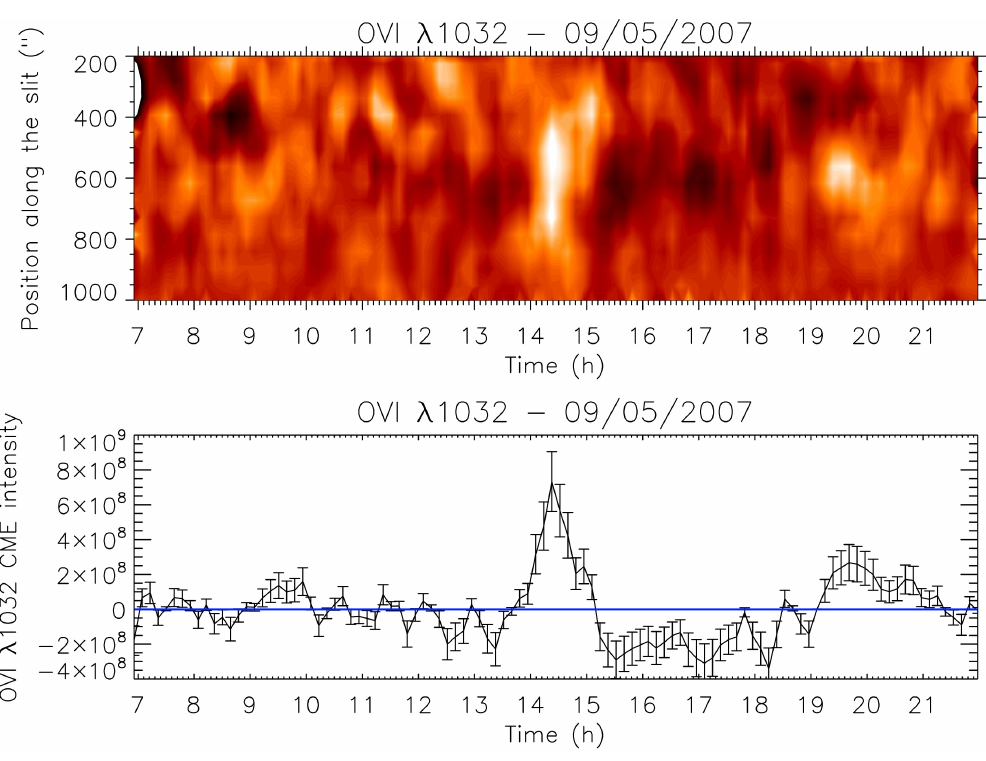
Fig. 7. Top: the evolution of the O VI λ 1031.9 line intensity along the southward part of the UVCS slit as a function of time. Positions along the slit (y-axis) are given in arcsecs measured from the slit center; the pre-CME average coronal intensity has been subtracted in order to enhance the visibility O VI line intensity increase occurring between ∼ 14:00 and 15:10UT and due the CME transit across the slit. Bottom: the O VI λ 1031.9 line intensity evolution averaged over the southward part of the UVCS slit shown in the top plot (average pre- CME intensity subtracted). The intensity peak between 14:00 and 15:10UT corresponds to the transit of the CME front, while the following intensity decrease can be interpreted as the CME